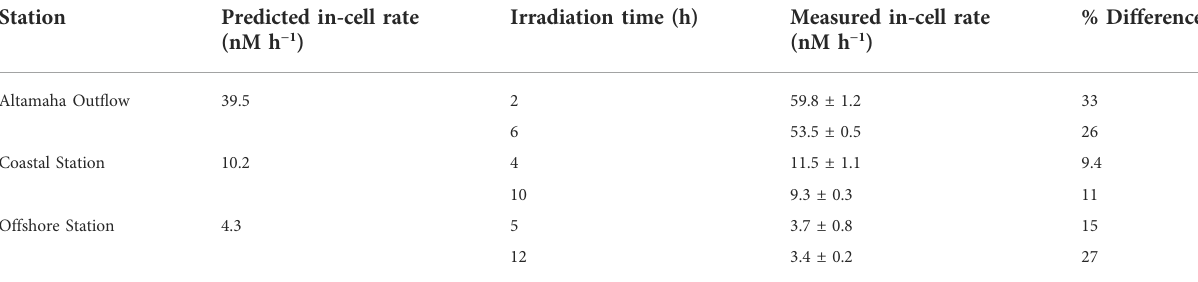
TABLE 3 Predicted H 2 O 2 photoproduction rates in the quartz irradiation cells using the “ marine-average ” AQY and measured H 2 O 2 photoproduction rates (± 1 SD) in fi ltered water samples at two time points. % differences between measured and predicted rates are also listed.